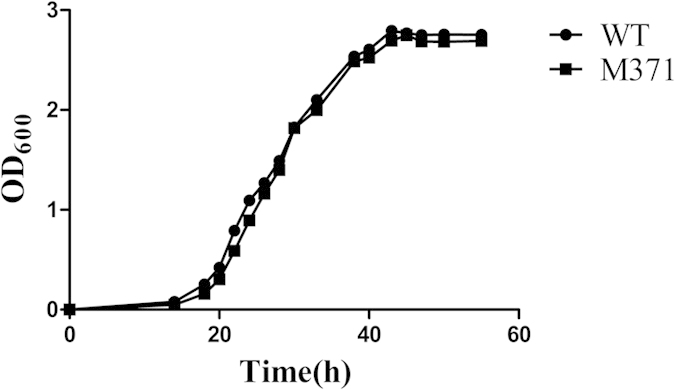
Growth of M. smegmatis mc2155 and M371.Mycobacterium smegmatis mc2155 and M371 were grown in Middlebrook 7H9 medium supplemented with 0.05% Tween80 and 0.2% glycerinum. The OD600 were determined at an interval of 4 h.